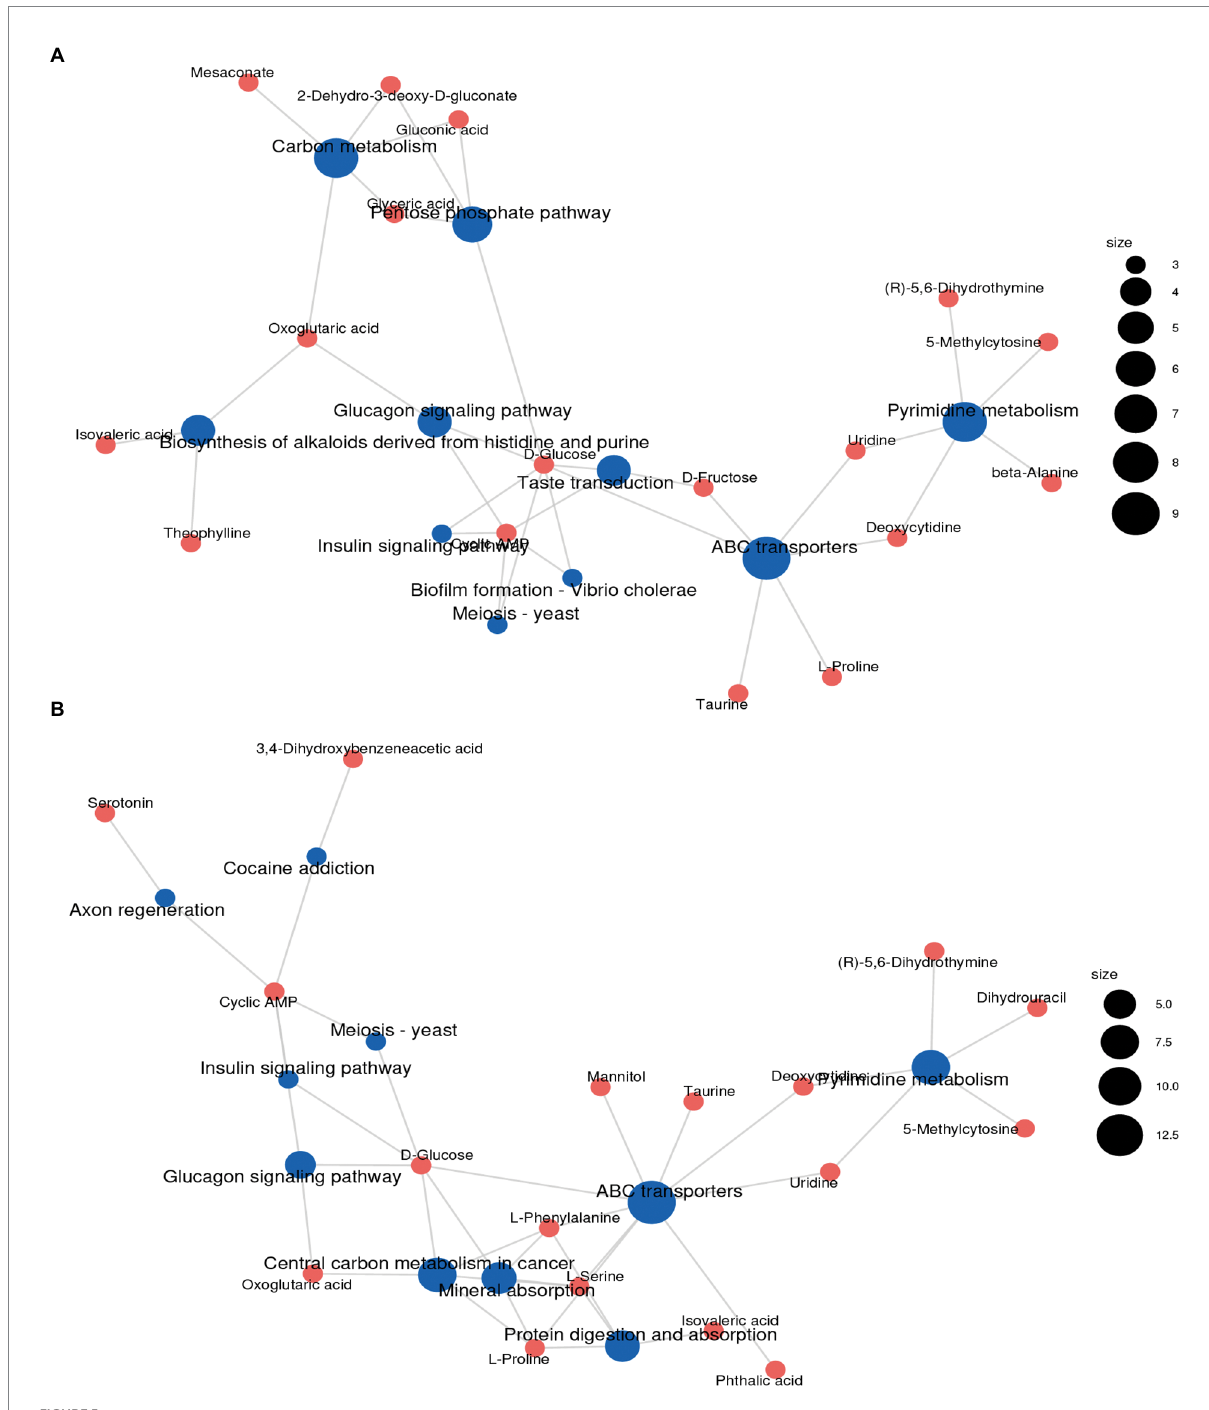
FIGURE 5 Metabolic pathway association networks. (A) After Lactobacillus plantarum R9 fermentation. (B) After Lactobacillus gasseri B1-27